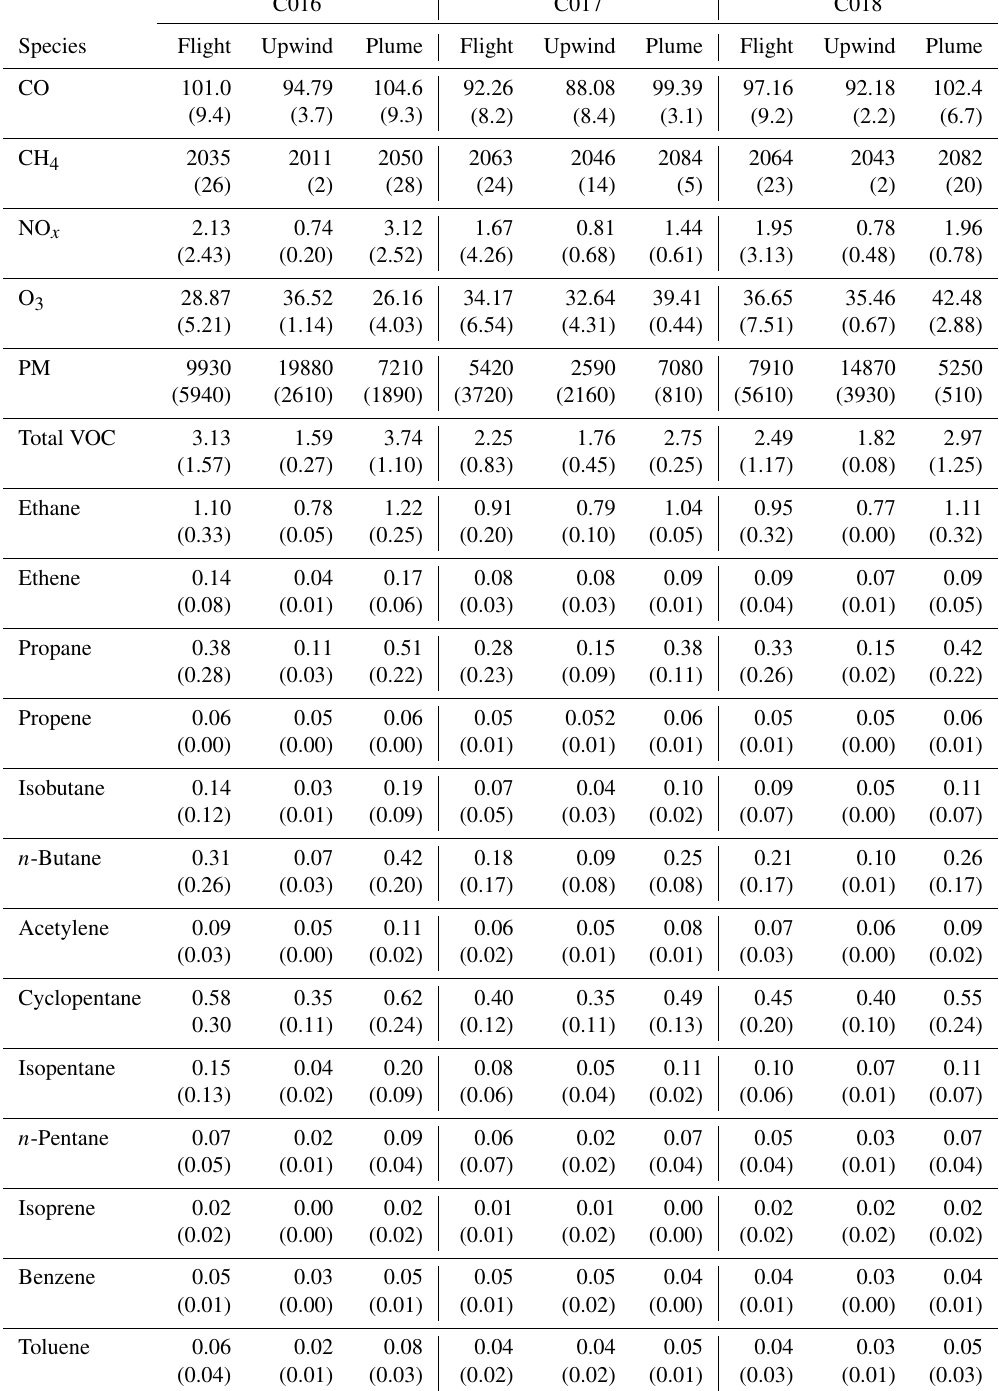
Table 1. Average concentrations of trace gases (ppbv) and particle number concentration (particulate matter, PM; cm − 3 ) for the whole flight, upwind segment and downwind reciprocal runs at an altitude corresponding to the upwind leg for each flight. Numbers in parentheses show ±